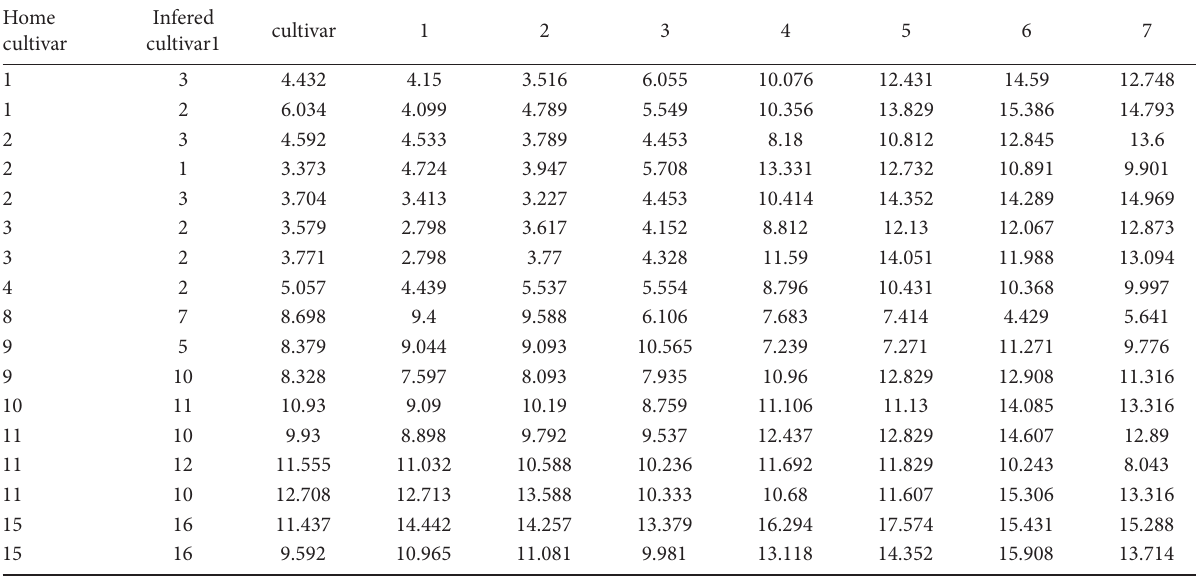
Table S6. Assignment result of date palms (only samples inferred to be from other populations are given) based on positive likelihood. (cul- tivar numbers are according to Table